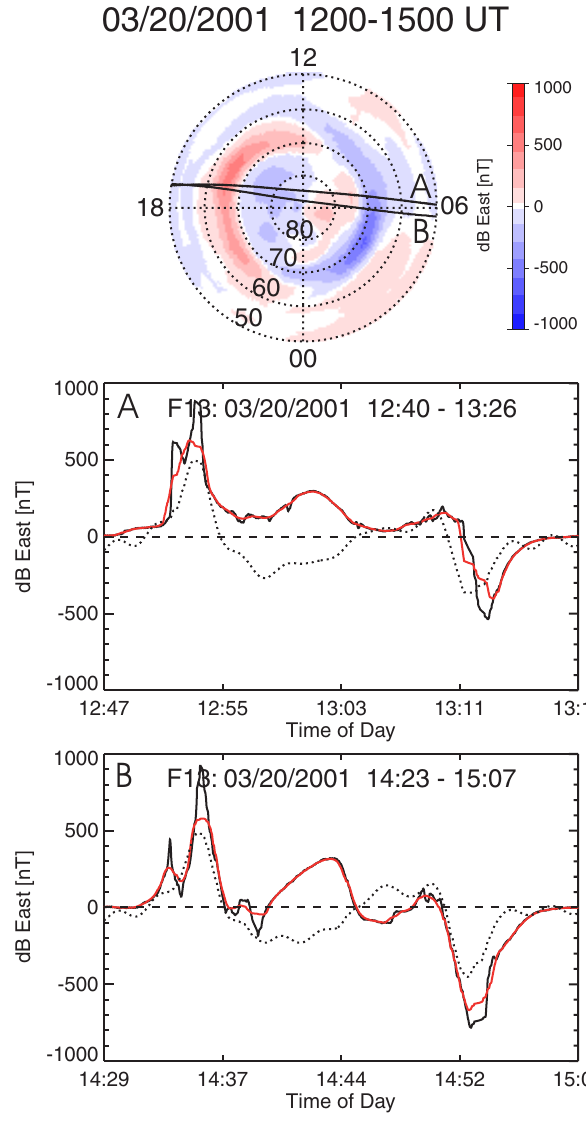
Fig. 9. Comparison of the fitted magnetic perturbations from Irid- ium (dotted line) with DMSP F13 observation (solid black line) dur- ing the interval 18 August 2003, 08:00–10:00UT. The red solid line shows the 50s boxcar average of the DMSP F13 data.